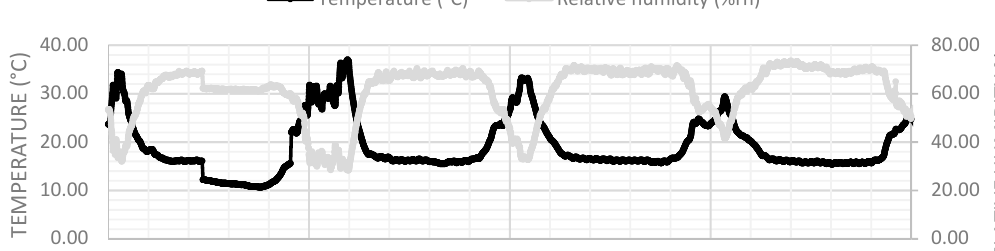
Figure 18. Measured temperature and relative humidity in the third week.